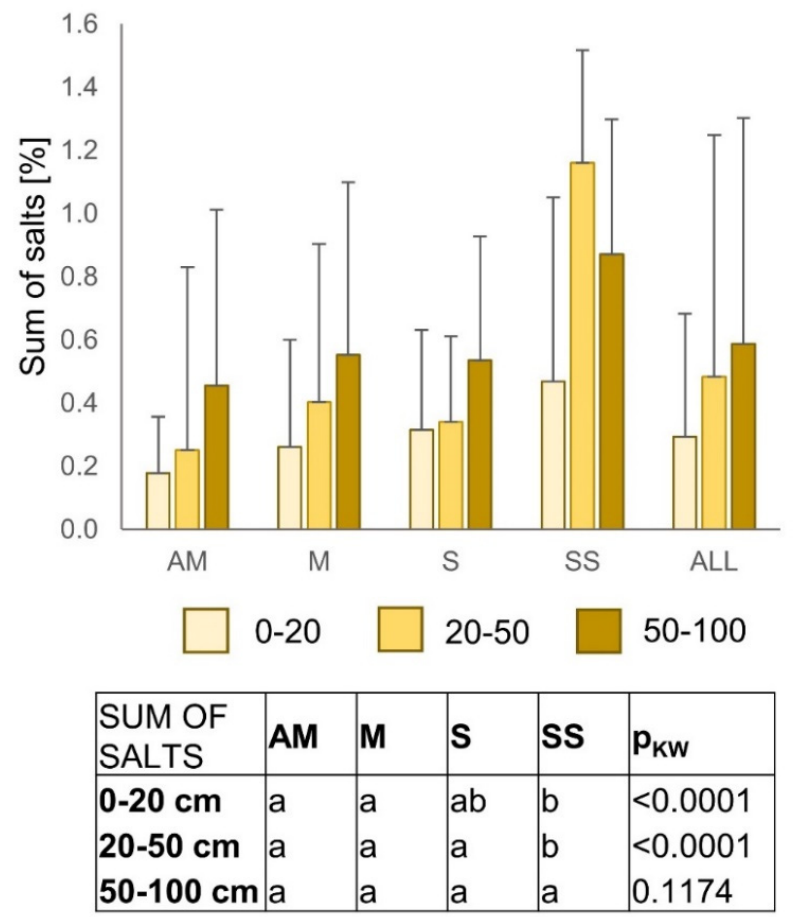
Figure 3. Mean sum of salts [%] in three horizons (A-0–20 cm, B-20–50 cm, and C-50–100 cm) of the studied soil types, with statistically significant differences between the studied soil types and p values in Kruskal–Wallis tests provided in the table. Abbr.: alluvial meadow soil (AM), meadow soils (M), serozems (S), and secondary solonchaks (SS). The mean content of cations (Na + , K + , Mg 2+ , and Ca 2+ ) and anions Cl − , SO 4 2 − , and HCO 3 2 − are shown in Figure 4.